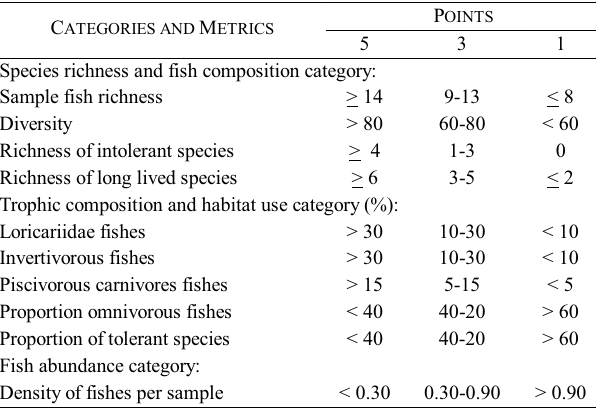
Table 1 . Categories and metrics considered in the model of index of biotic integrity (IBI). Explanations in